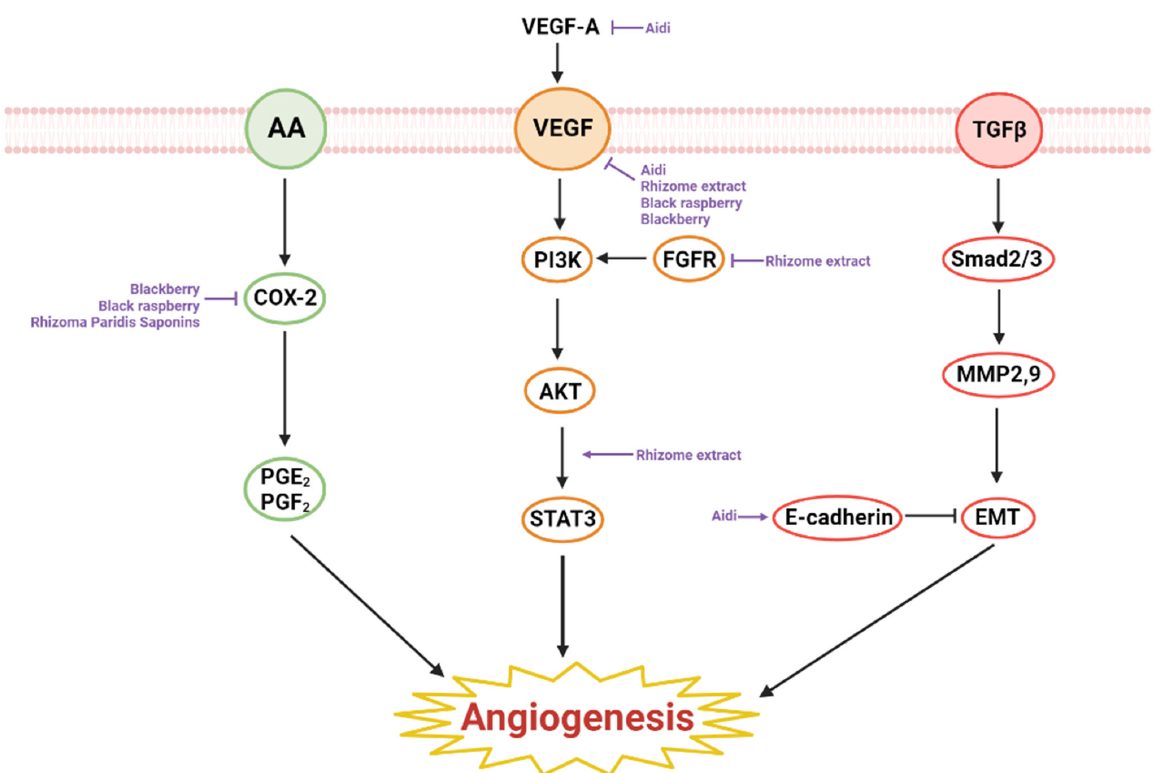
Figure 2. Schematic diagram of angiogenesis ‐ inhibiting natural products in esophageal